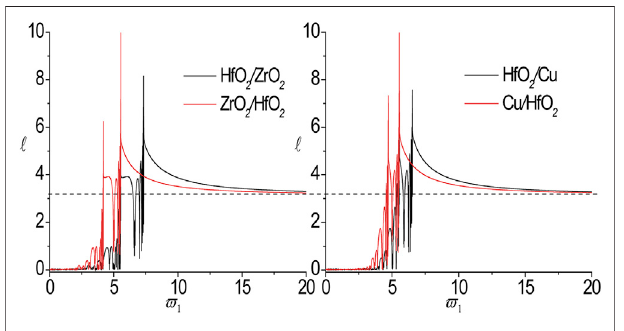
FIGURE 4 | The in fl uences of the mateiral component order on the lovalization factors of the Thue-Morse systems aperiodic systems.